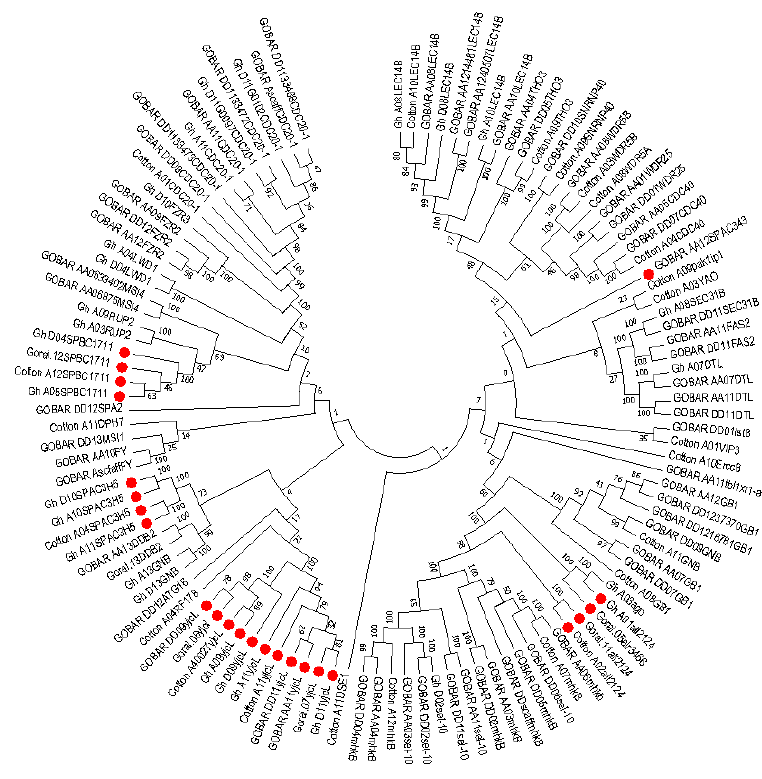
Figure 7. Evolutionary relationship of 115 genes belonging to protein domains of DUF819 (PF005684) and WDR (PF00400) in Gossypium arboreum , G. raimondii, G. hirsutum, and G. barbadense. The phylogenetic tree was constructed using MEGA software ver. 7.0 by the neighbor-joining method. The parameters were 1000 bootstraps and pairwise deletion. The 24 uncharacterized genes are indicated by red dots in four Gossypium species.